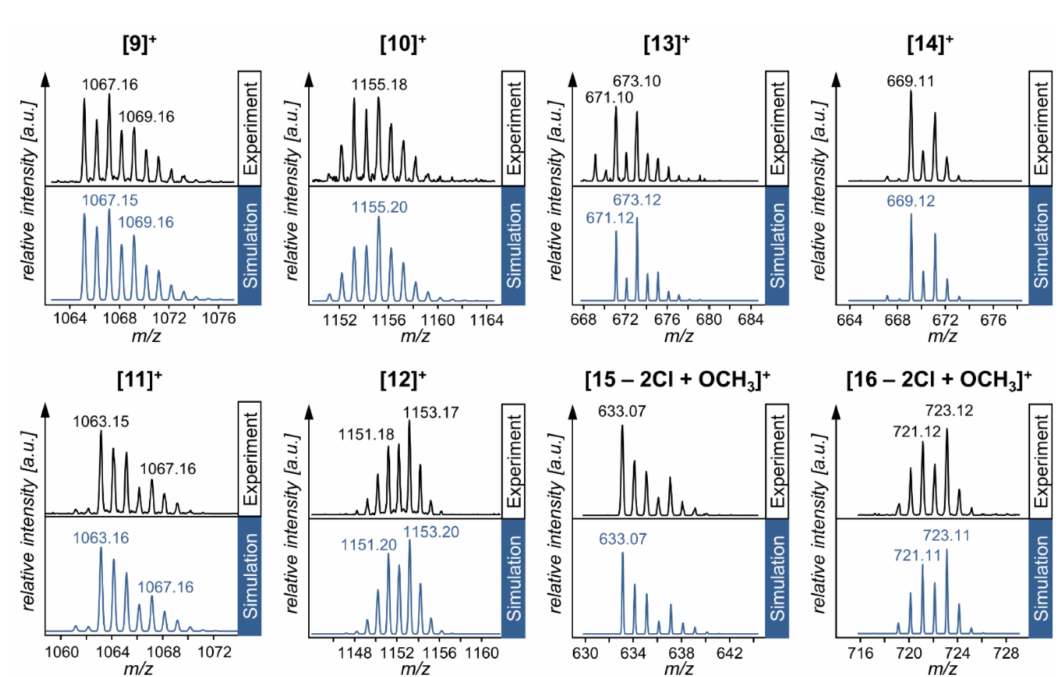
Figure 1. The experimental and theoretical isotopic distributions of the four investigated hetero-dimetallic complexes ( 9 – 12 ) and their synthetic precursors ( 13 – 16